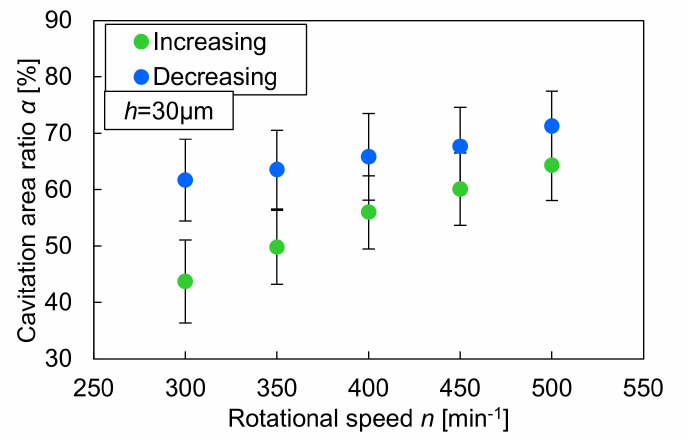
Figure 11. The relationship between cavitation area ratio and rotational